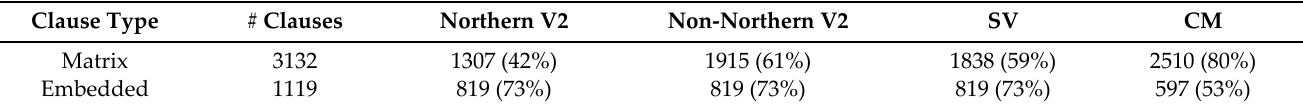
Table 3. Parsing success of four competing grammars in matrix and embedded